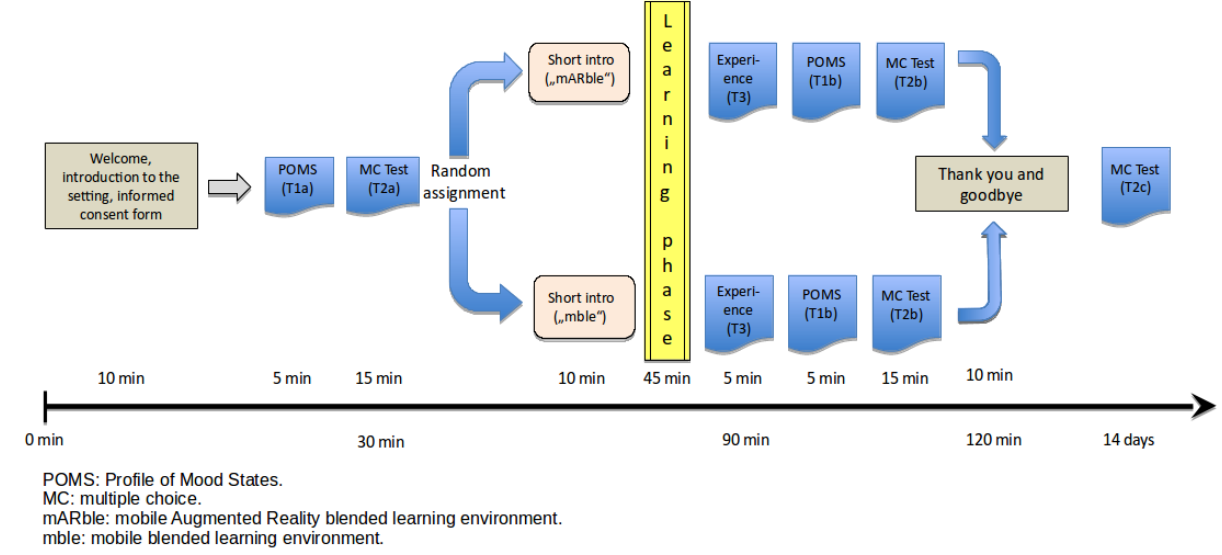
Figure 1. Schedule and tests that were performed. Throughout the text, individual steps or tests are referenced with the labels shown in this figure (T1a/b, T2a/b/c, and